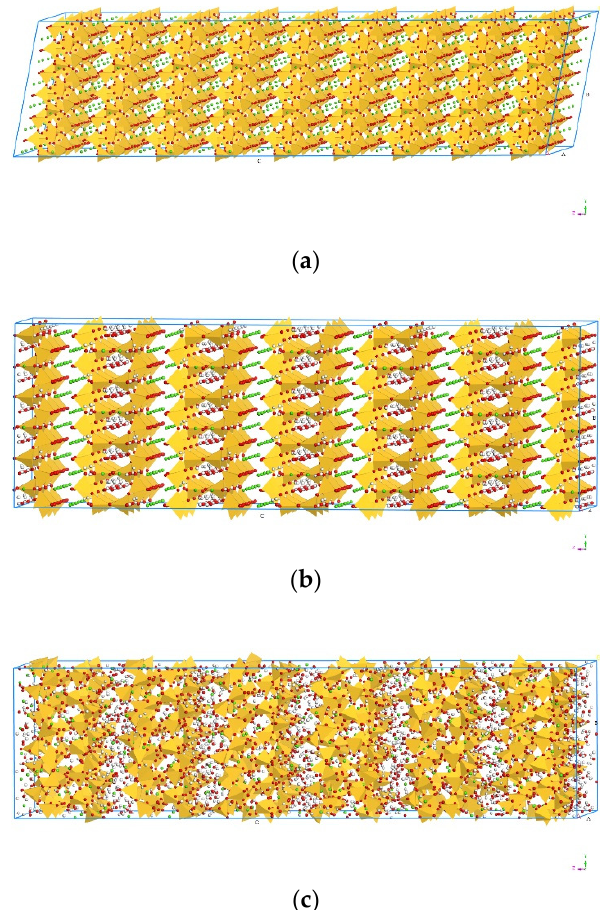
Figure 3. Molecular structure of Tobermorite: ( a ) Tobermorite 9 Å, ( b ) Tobermorite 11 Å, ( c ) Tobermorite 14 Å (Color legend: hydrogen H (white); calcium Ca (green); oxygen O (red); silica Si (yellow polyhedral)).